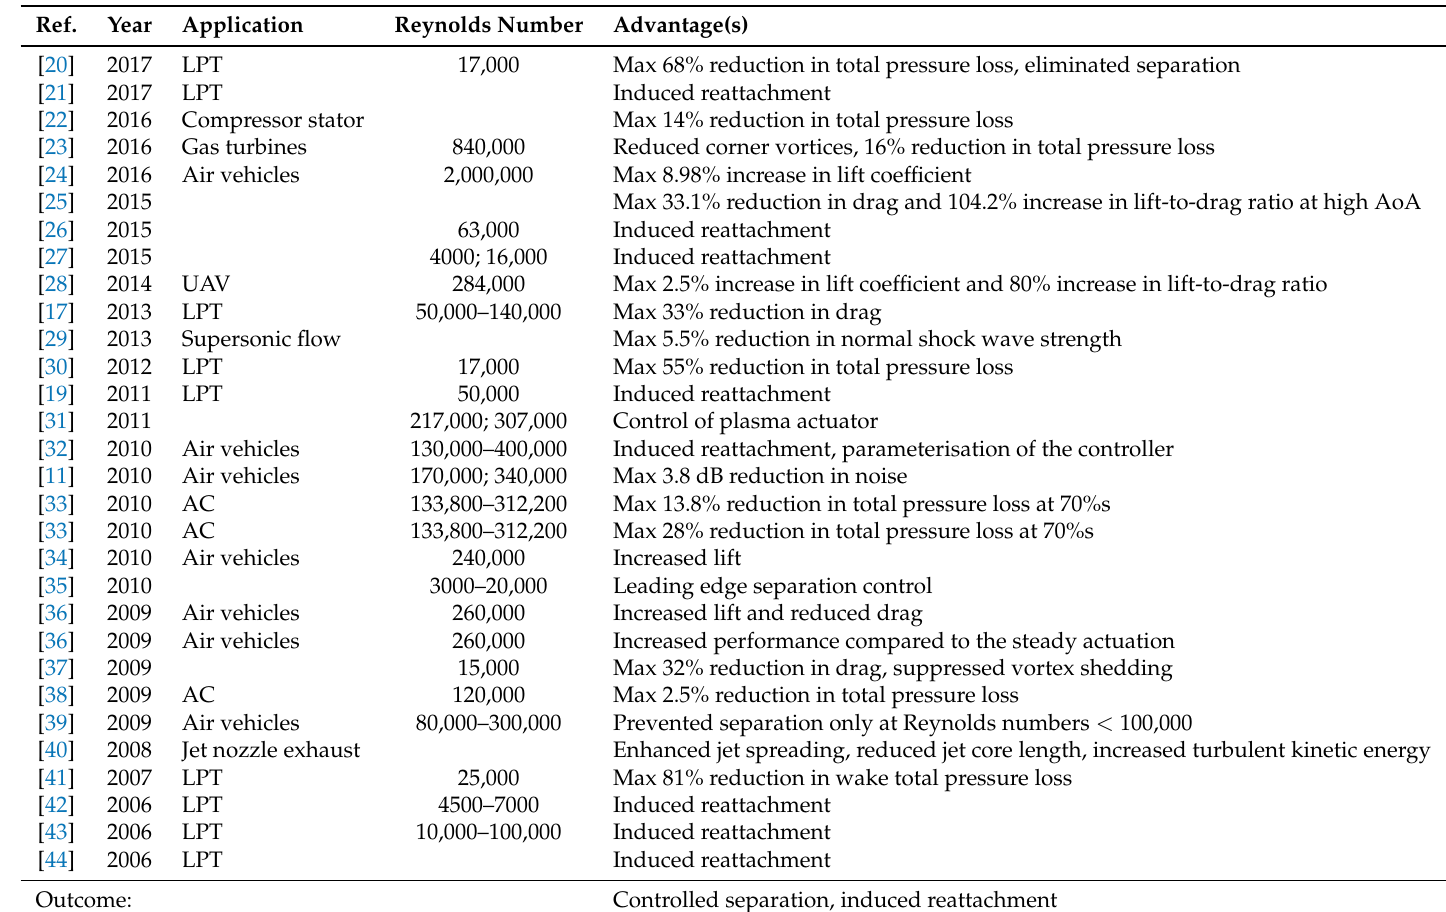
Table 3. Representative summary of plasma actuator